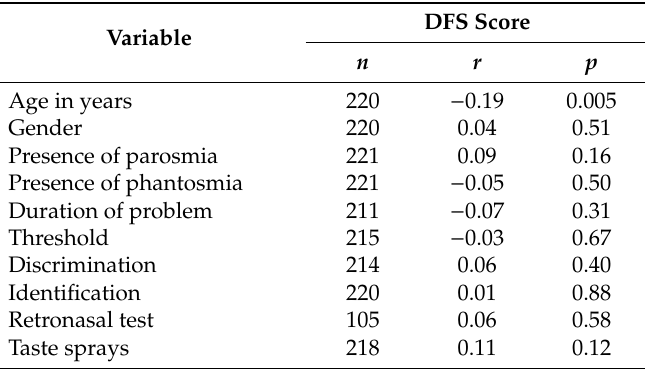
Table 2. Zero order correlations for the whole sample between Western-diet score (Dietary fat and sugar scale: DFS) and the other